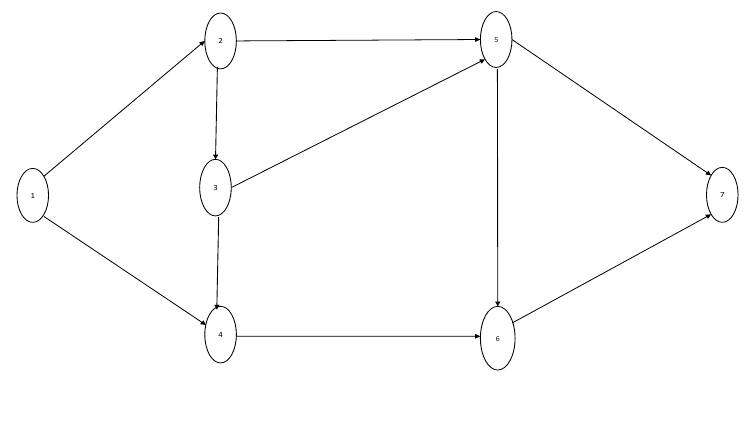
Figure 1: I-VTPF directed